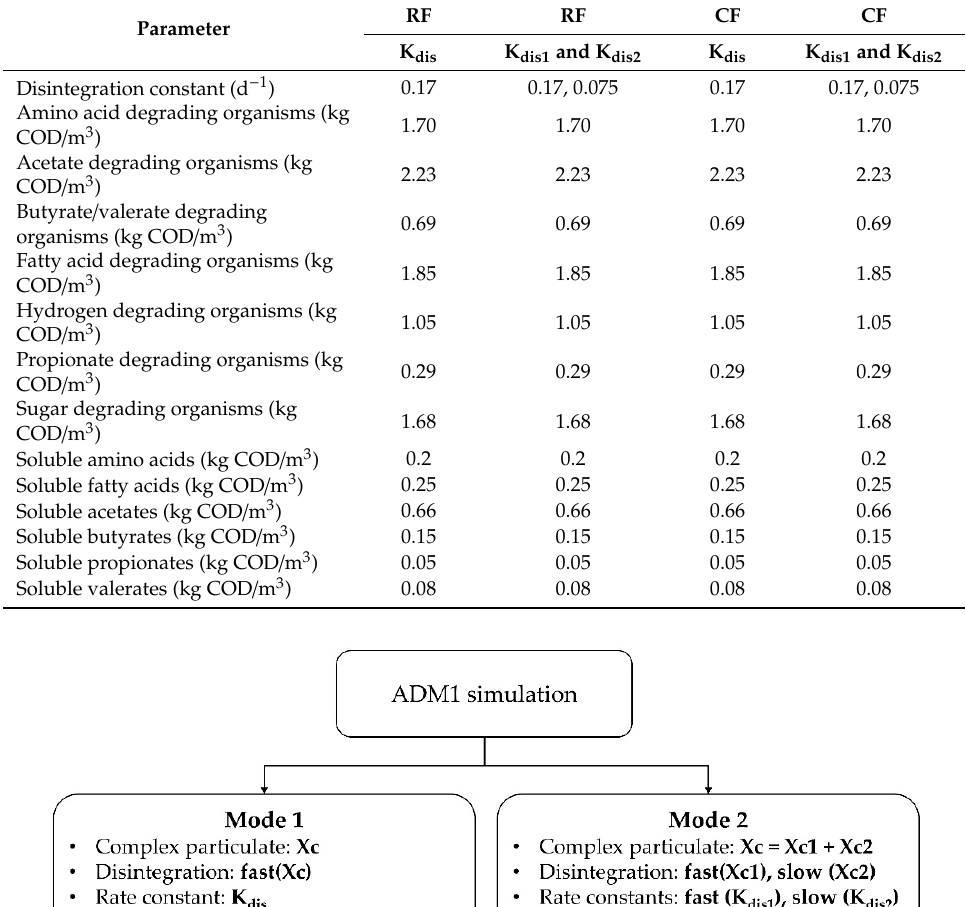
Table 4. Selected simulation parameters and values used to implement ADM1 in Aquasim.